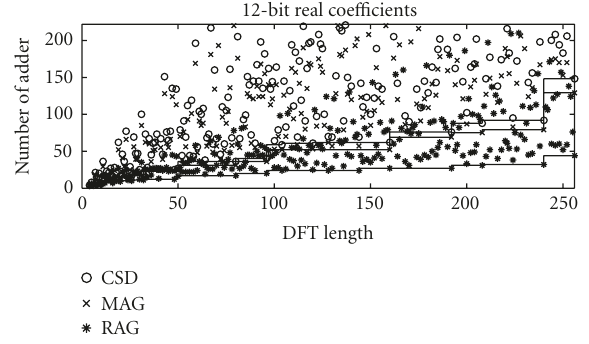
Figure 4: E ff ort for a real coe ffi cient multiplier block design in the Bluestein chirp- z algorithm. The solid line shows the maximum transform length for a specific cost value.